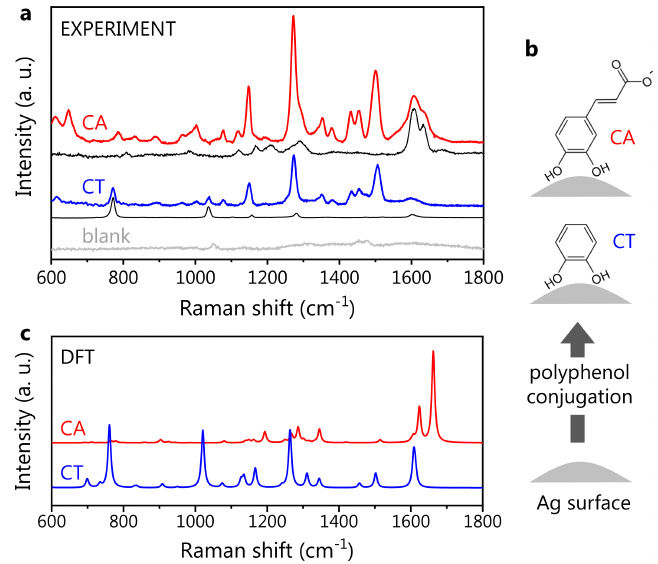
Figure 3. Polyphenol SERS signature. ( a ) Experimental SERS spectra of CA (red) and CT (blue), both obtained with Hyd@AgNPs as SERS substrate. The blank Hyd@AgNP spectrum is shown in light gray. Under each SERS spectrum, we reported the corresponding Raman one (black), collected in a water solution at neutral pH. For a description of data normalization, see the text. ( b ) Sketch showing the hypothesized molecular orientation for CA and CT, with the CT moiety adjacent to the AgNP surface. ( c ) Theoretical SERS spectra of CA (deprotonated form) and CT. These were calculated as a weighted average of different coordination complexes, i.e., interacting configurations between the molecule and a silver atom (see Section C of Supplementary